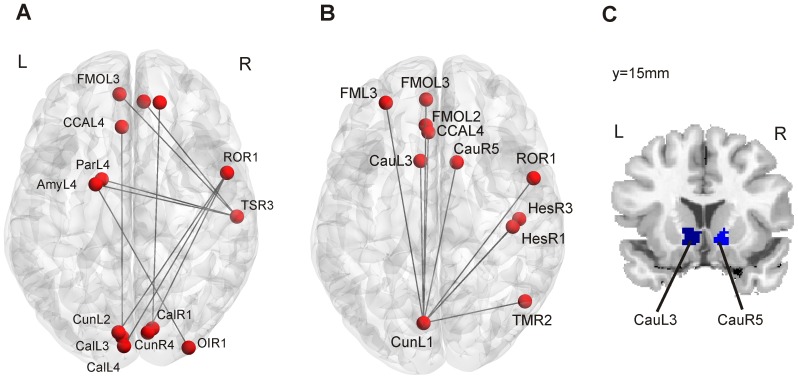
Altered connectivity of the visual network.A) Altered connectivity of nodes in module 4 (visual network). We observe stronger occipital-frontal and occipital-temporal connectivity for healthy controls. B) Altered connectivity of the cuneus node CunL1. C) Coronal view showing the anatomical location of the two caudate nodes CauL3 and CauR5. Abbreviations: Amy: Amygdala; Cal: Calcarine; Cau: Caudate; Cun: Cuneus; CCA: anterior cingulate cortex; FMO: medial orbitofrontal cortex; Hes: Heschl gyrus; OI: inferior occipital cortex; Par: parahippocampus; RO: rolandic operculum; TM: medial temporal gyrus; TS: superior temporal gyrus.